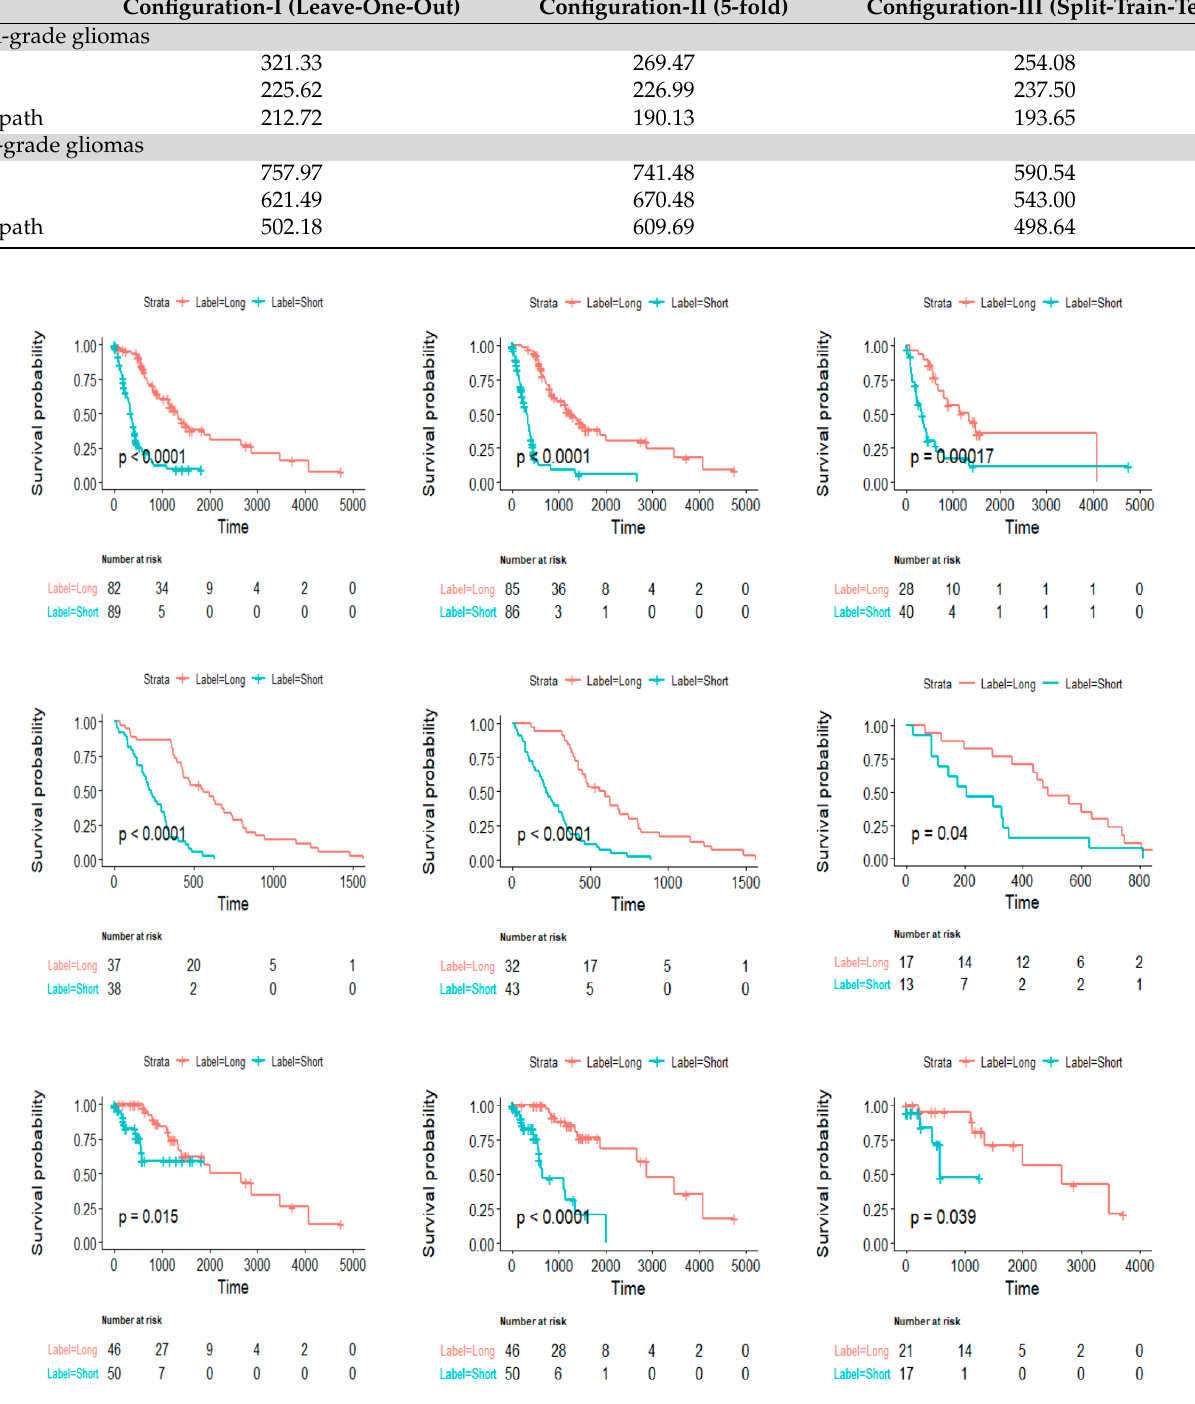
Figure 3. Kaplan–Meier curves for survival experiment. The x-axis shows the actual in days and the y-axis shows the cumulative survival probability. Left to right, respectively, show classification results of LOO, 5-fold and split-train-test configurations. Top to bottom show HGGs + LGGs, HGGs, and LGGs datasets,